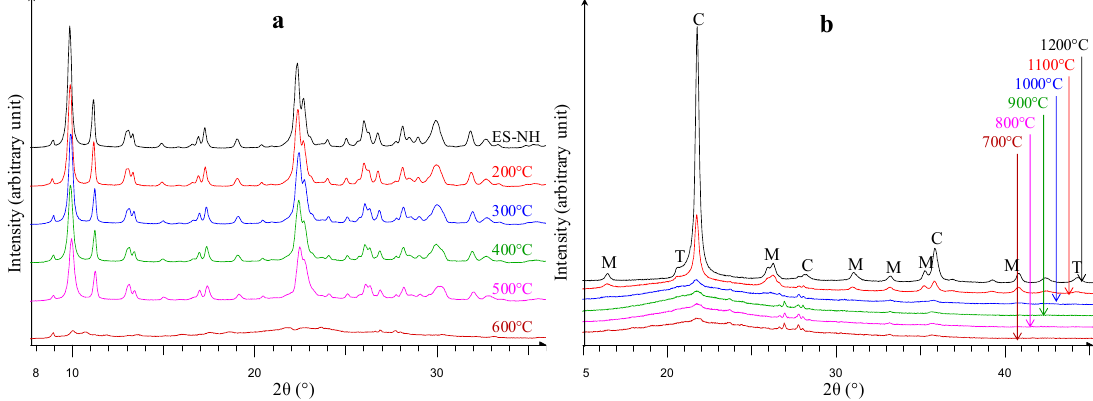
Figure 1. ( a ) X-ray Diffraction (XRD) patterns of ES-NH unheated and treated for 2 h from 200 to 600 °C and; ( b ) from 700 to 1200 °C. C = Cristobalite; M = Mullite; T = Tridymite.